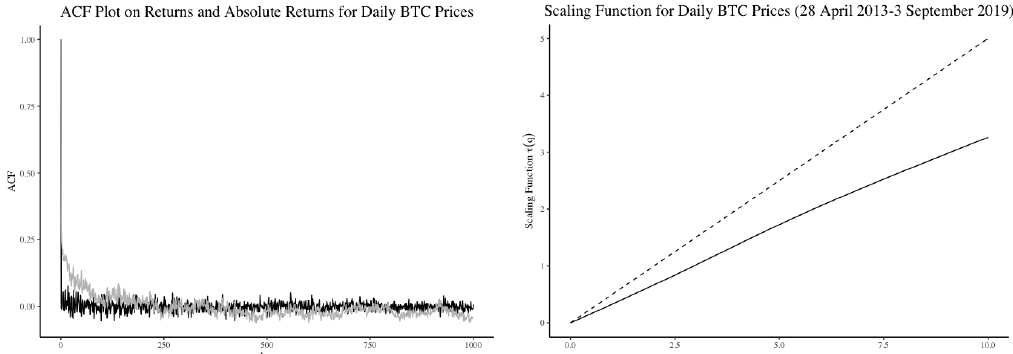
Figure 6. Left —Autocorrelations of mean-centered log-returns (black) and absolute returns (grey) for daily Bitcoin open price (28 April 2013–3 April 2019). Right —Scaling function for daily Bitcoin open price (28 April 2013–3 September 2019). The dashed line is the q /2 reference line (same for all the scaling function